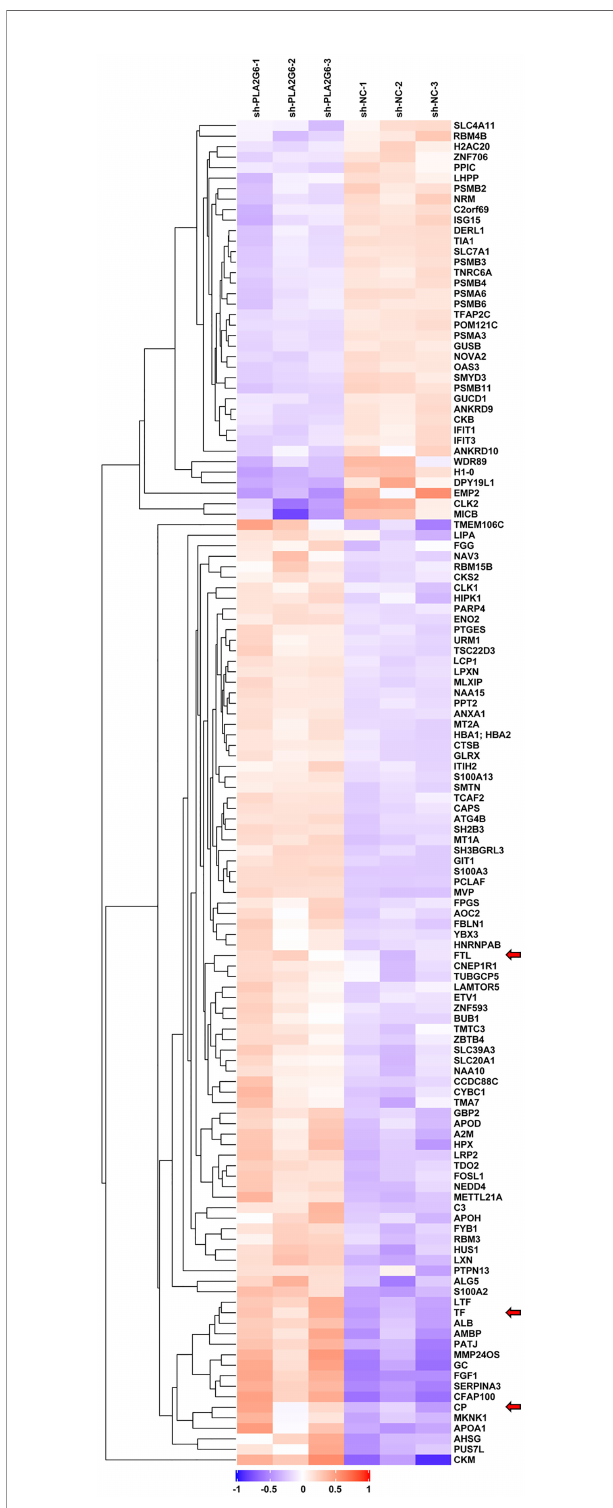
FIGURE 6 | The heat map displays protein expression changes in the 3 PLA2G6 knockdown-treated and 3 control samples. Red, white, and blue represent increased, unchanged, and decreases expression, respectively. Three ferroptosis-related DEPs were indicated by red